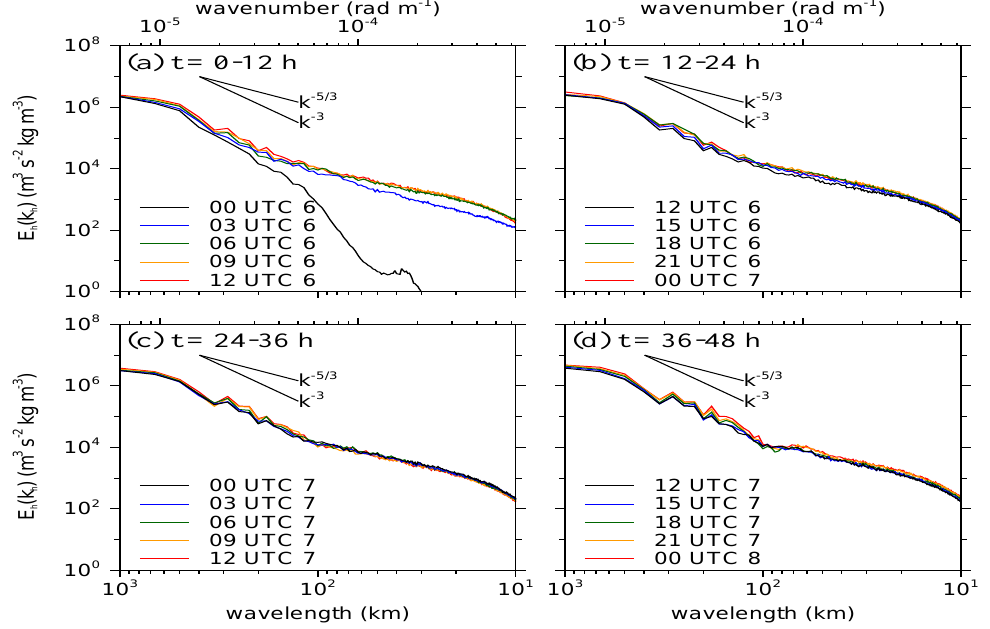
Figure 3. Time evolution of the horizontal kinetic energy (HKE) spectrum [ E h ( k h )] averaged vertically over the troposphere for ( a ) 0–12 h, ( b ) 12–24 h, ( c ) 24–36 h, and ( d ) 36–48 h. Spectra are plotted every 3 h. The reference lines correspond to the − 3 and − 5 / 3